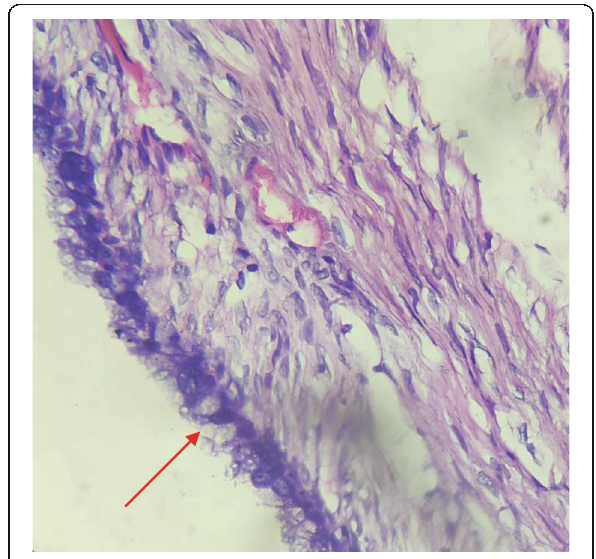
Fig. 4 Showing Hematoxylin and Eosin (magnification 400x) photomicrographs of a Mucinous Cystadenoma showing a cyst wall with lining epithelium composed of benign looking goblet cells (red arrow) with collagenised